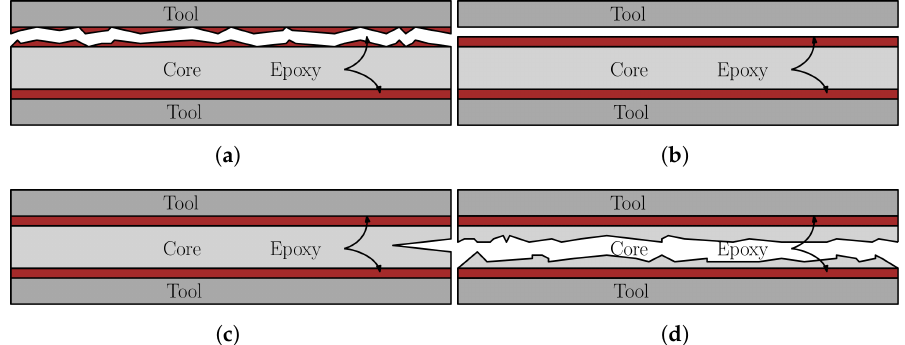
Figure 8. Four distinct failure modes were observed for LC 1. The failure modes presented in ( a , b ) corresponds to the performance of the bond, where a cohesive and adhesive failure are presented. In ( c , d ), the failure modes are related to the fracture of the core. In ( c ), the crack initiates from one of the edges and grows as loading proceeds. In ( d ), a brittle fracture occurs simultaneously over the specimen width.